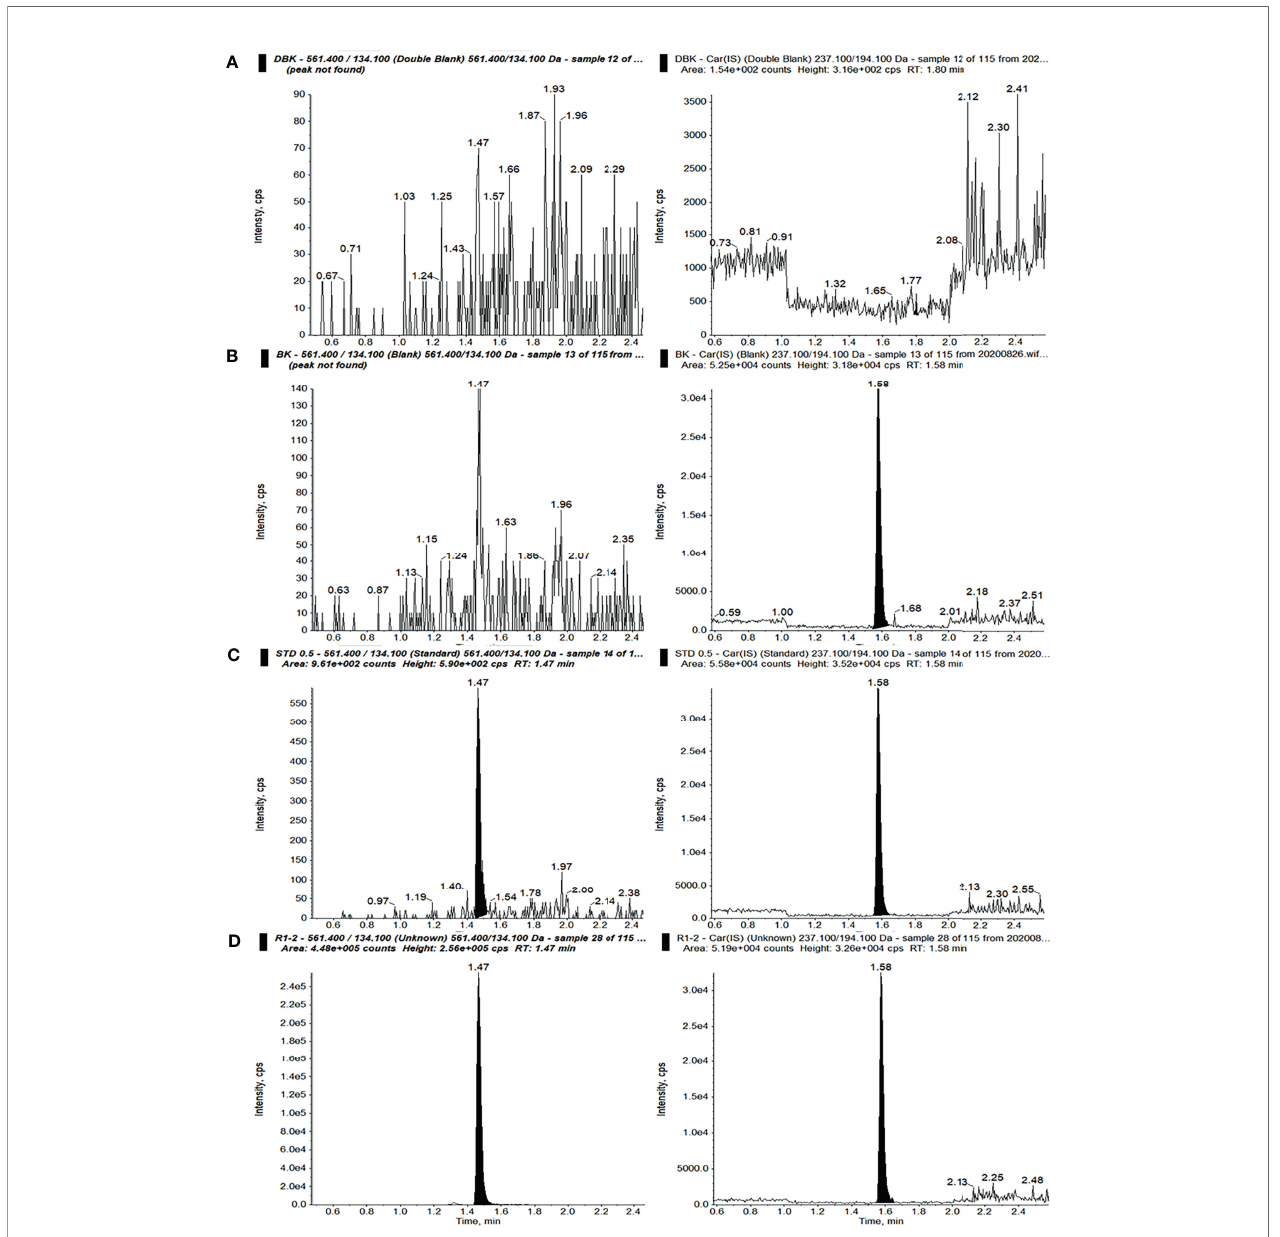
FIGURE 2 | Ion chromatograms of sotorasib ( left ) and the internal standard (IS) ( right ) in double-blank plasma without analyte and IS (A) , blank plasma with IS (B) , blank plasma with sotorasib at the lower limit of quantitation (LLOQ) with IS (C) , and an unknown sample after administration of a 10-mg/kg dose of sotorasib (D) (298.36 ng/ml, 15 min after administration).